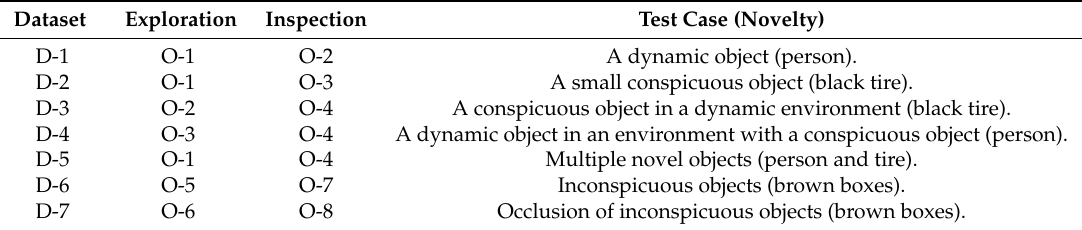
Table 3. Data partition for novelty detection.